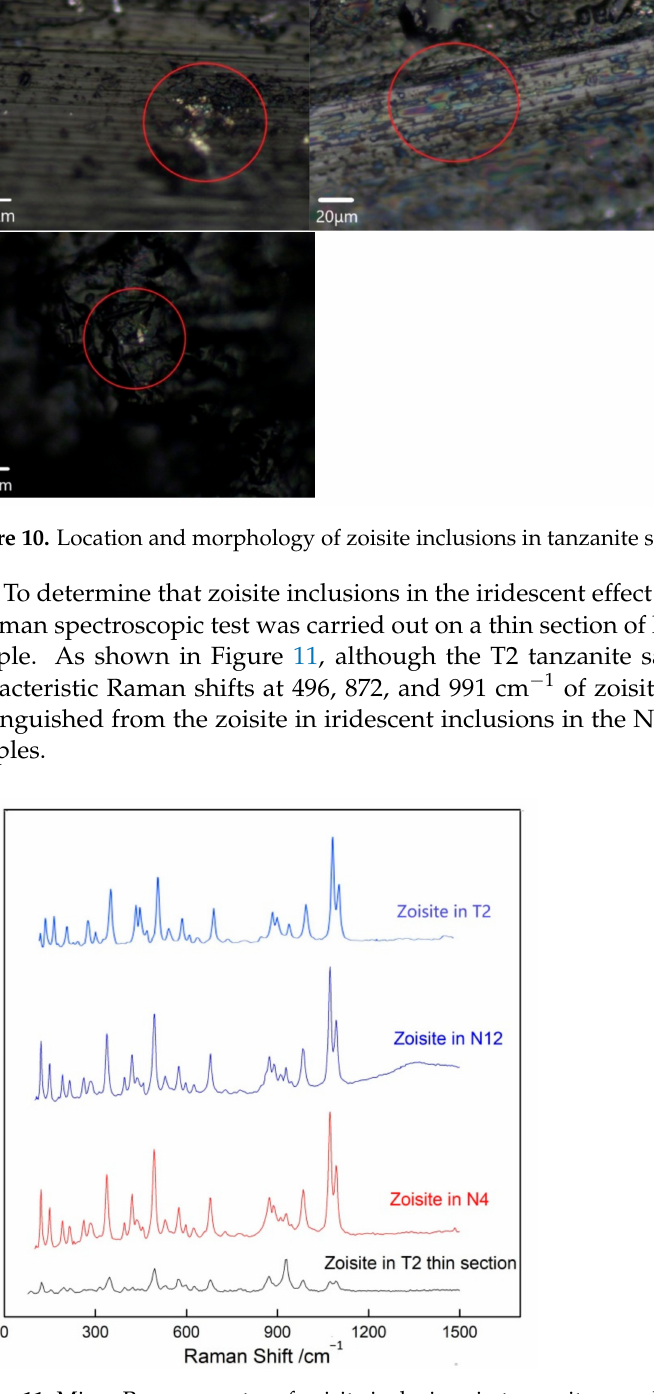
Figure 11. Micro-Raman spectra of zoisite inclusions in tanzanite samples N4, N12 and T2. Raman spectra of zoisite in natural and heat-treated samples are generally consistent in the 50 to 1100 cm − 1 range (Figure 11). Raman shifts at 334 cm − 1 of N8, N12, and T2 samples are attributed to the rotational vibration of [SiO 4 ] tetrahedra or the advective vibration of the metal M-O bond. Raman shifts of 493, 575, and 678 cm − 1 are assigned